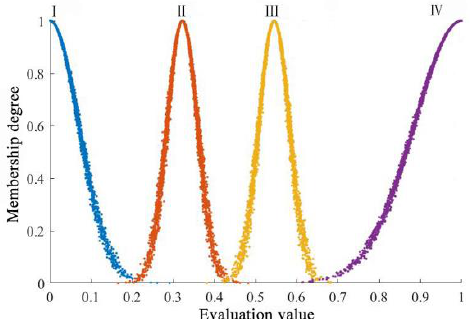
Figure 5. Comprehensive standard cloud model of all causing factors.